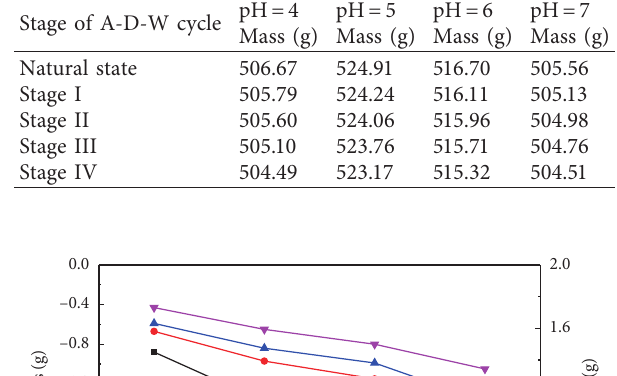
sandstone specimens after completion of different A-D-W